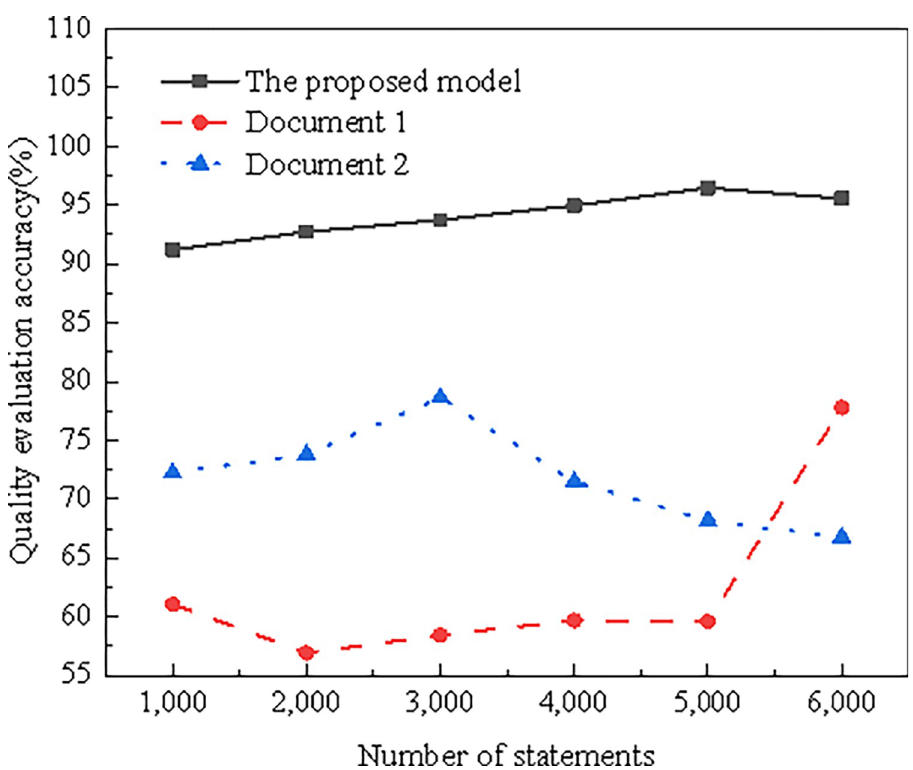
Fig 11. Comparison of model accuracy under different numbers of